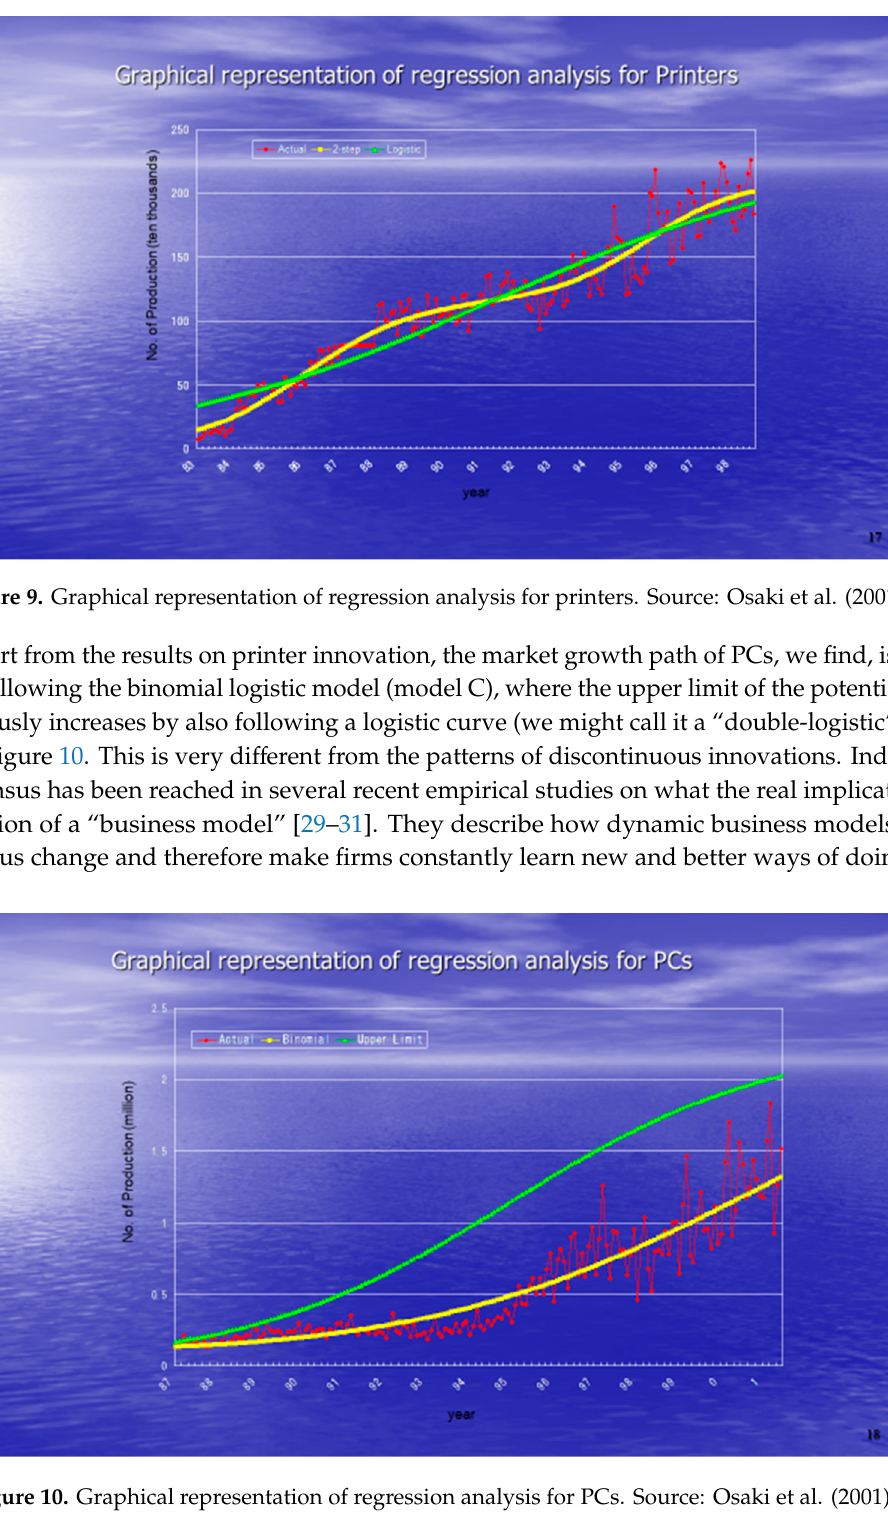
Figure 8. Graphical representation of regression analysis for televisions. Source: Osaki et al. (2001) [26].